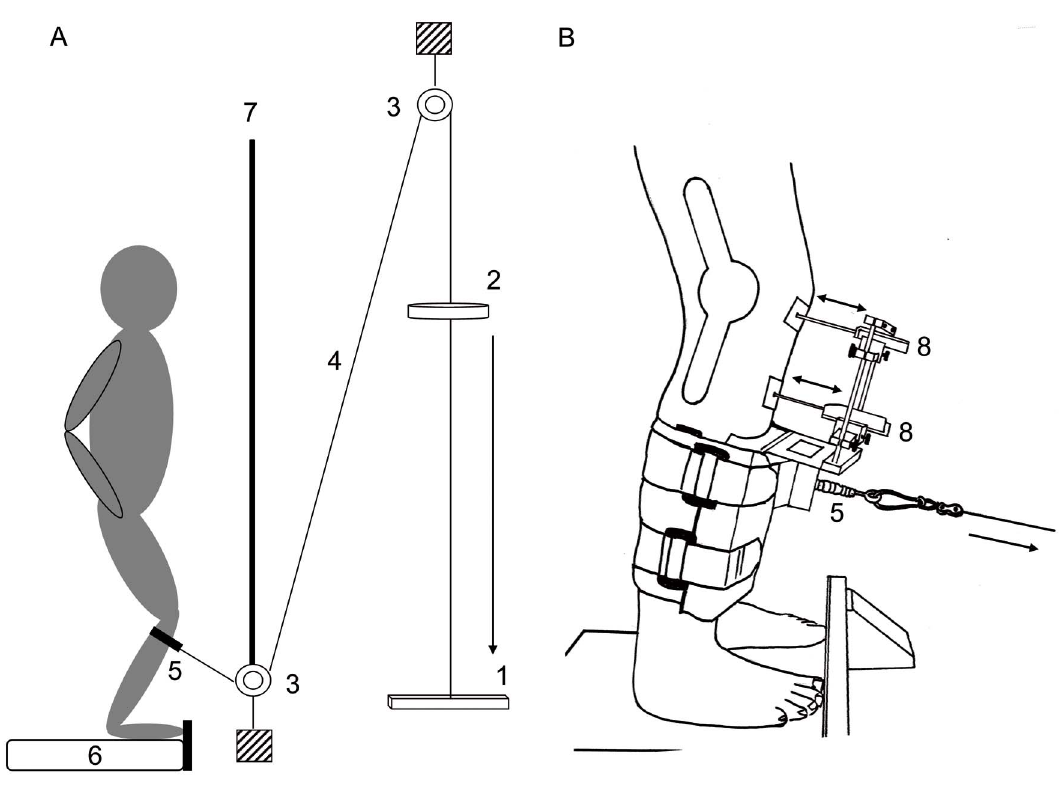
Figure 1. Schematic drawing of the experimental setup. A: Experimental setup, B: Measurement system | 1: stopper, 2: falling weight, 3: pulley, 4: steel rope, 5: force transducer, 6: force plate, 7: visual cover, 8: linear potentiometer. Arrows indicate the direction of the force. Posterior-anterior tibial translation was assessed by two linear potentiometers (8) placed on the patella and the tibial tuberosity. A force transducer (5) was used to measure the force transmitted to the